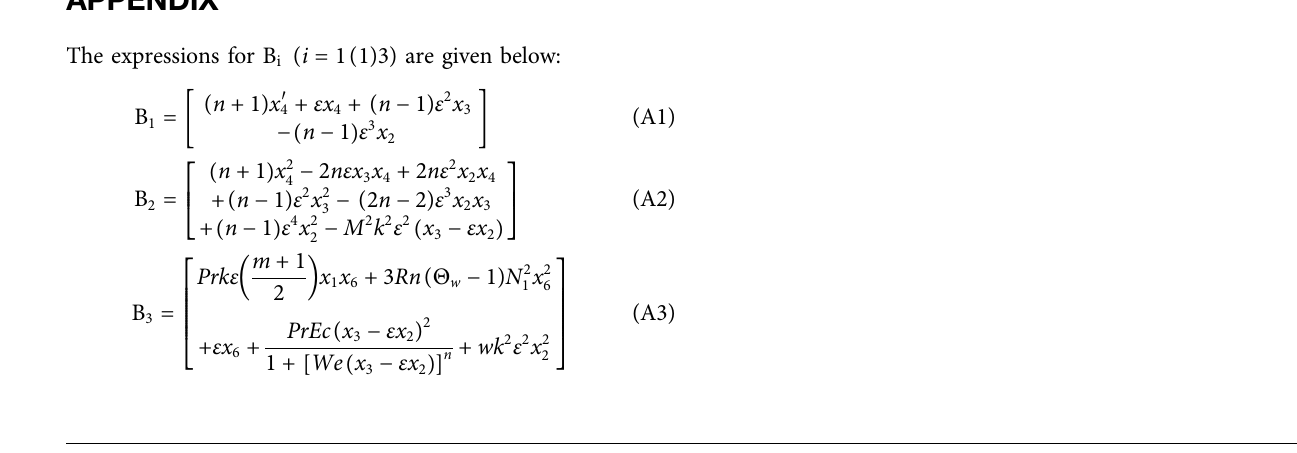
TABLE A1 | Numerical values of f ′ ( 0 ) , − Φ ′ ( 0 ) , and − Φ ′ ( 0 ) when for n (cid:2) 2, m (cid:2) 2, Pr (cid:2) 2, and Θ w (cid:2) 1 .